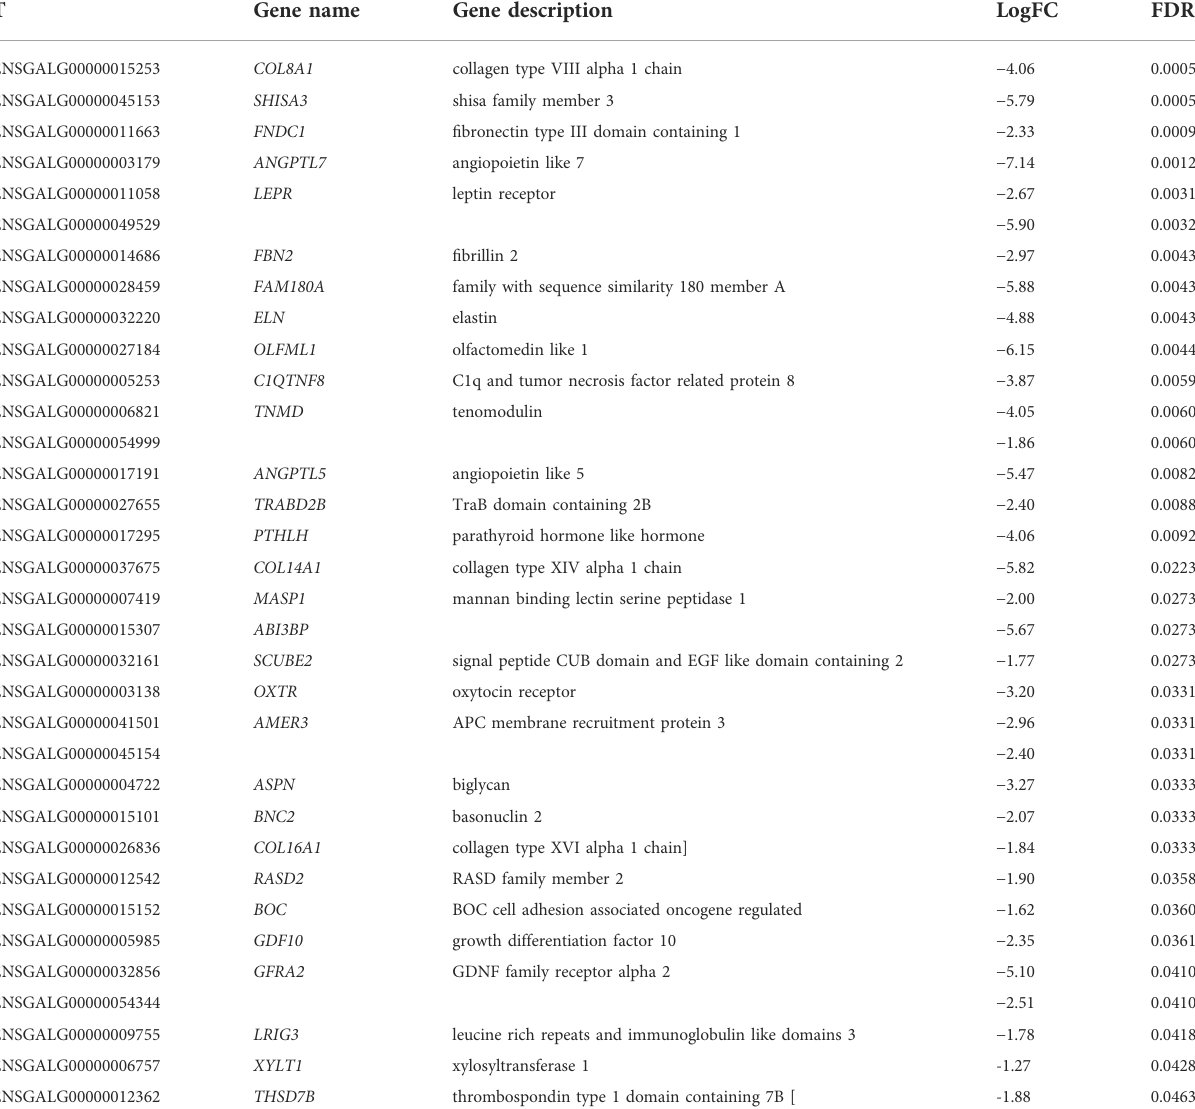
TABLE 2 Differentially expressed genes downregulated in FHS-affected broilers, according to